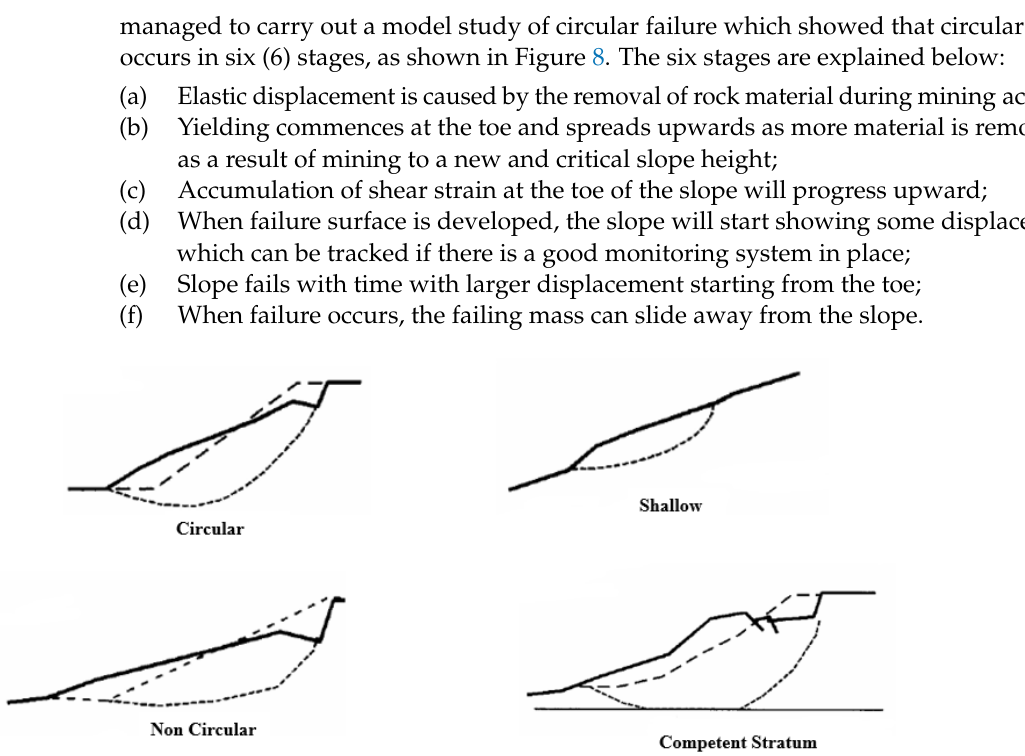
11 Figure 7. Rotational failure mode and circular failure mode in slopes (Adapted from [5]). In weak strata such as soil or deeply weathered rock, the circular failure is defined by a single discontinuity surface but will tend to follow a circular path [53]. However, if